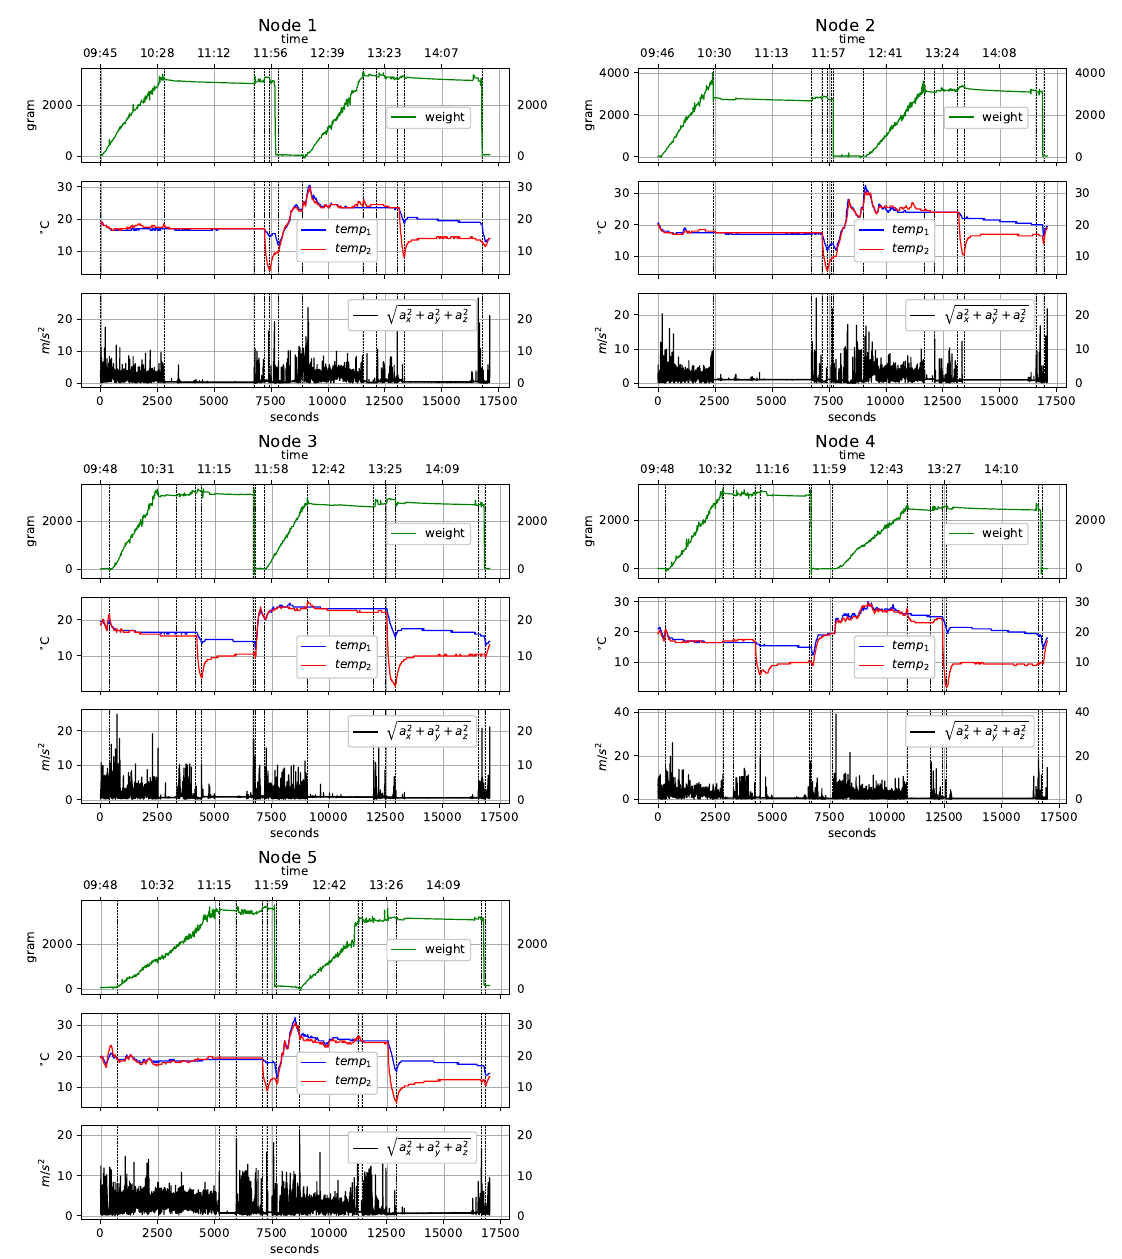
Figure 5. Visualization of the measures from the five monitoring nodes. Here the temperature, weight and vibration variables are observed during the harvest process synchronized on the time scale. The variables temp 1 (blue) and temp 2 (red) represent the lower and upper temperature in the harvest basket,